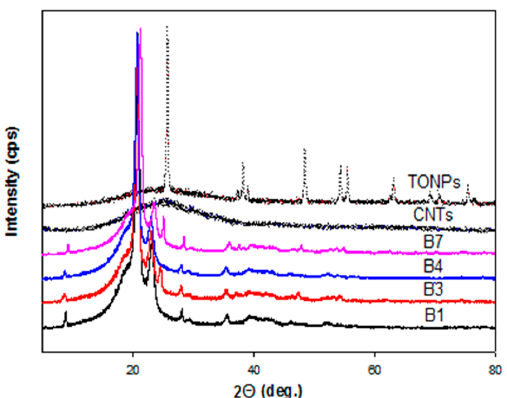
Figure 2. X-ray diffraction (XRD) patterns of TiO 2 powder, carbon nanotubes (CNTs), pristine low-density polyethylene (LDPE), and the representative composite films.